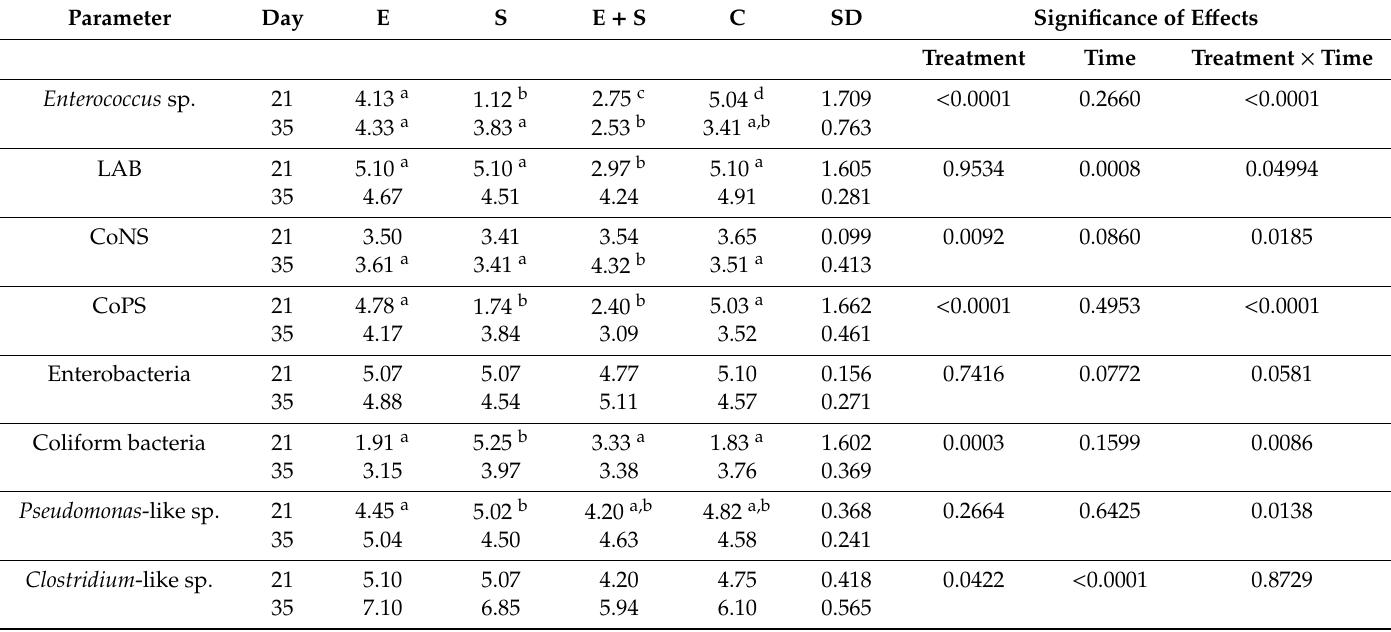
Treatment Time Treatment × Time